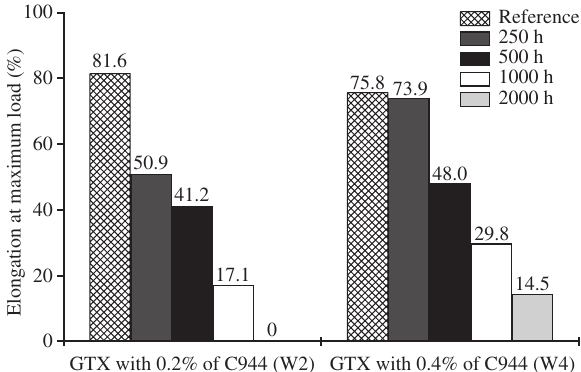
Figure 5 Retained tensile strength of the GTXs W2 and W4 after artifi cial weathering.